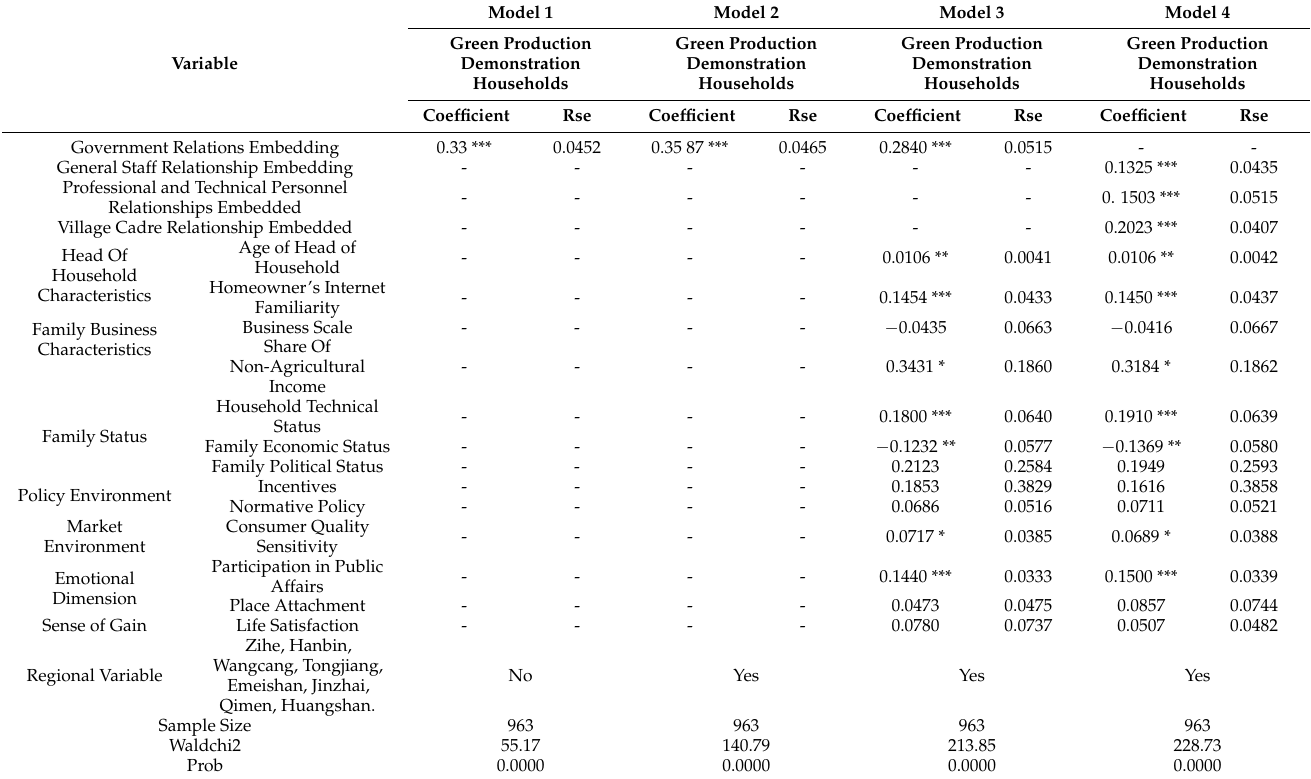
Table 4. Results of Benchmark